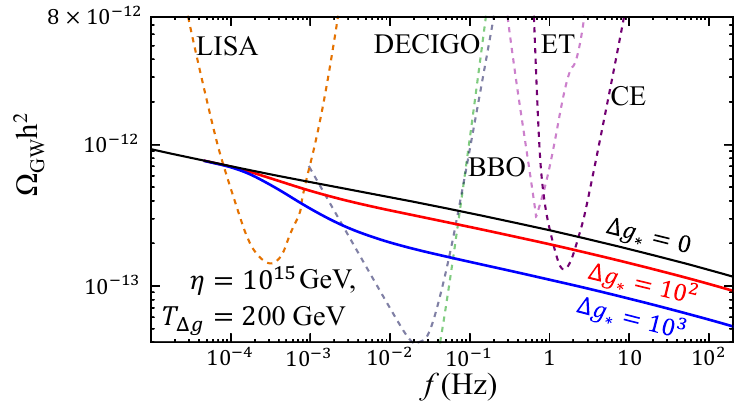
= 200 GeV. In the example shown, ∆ g